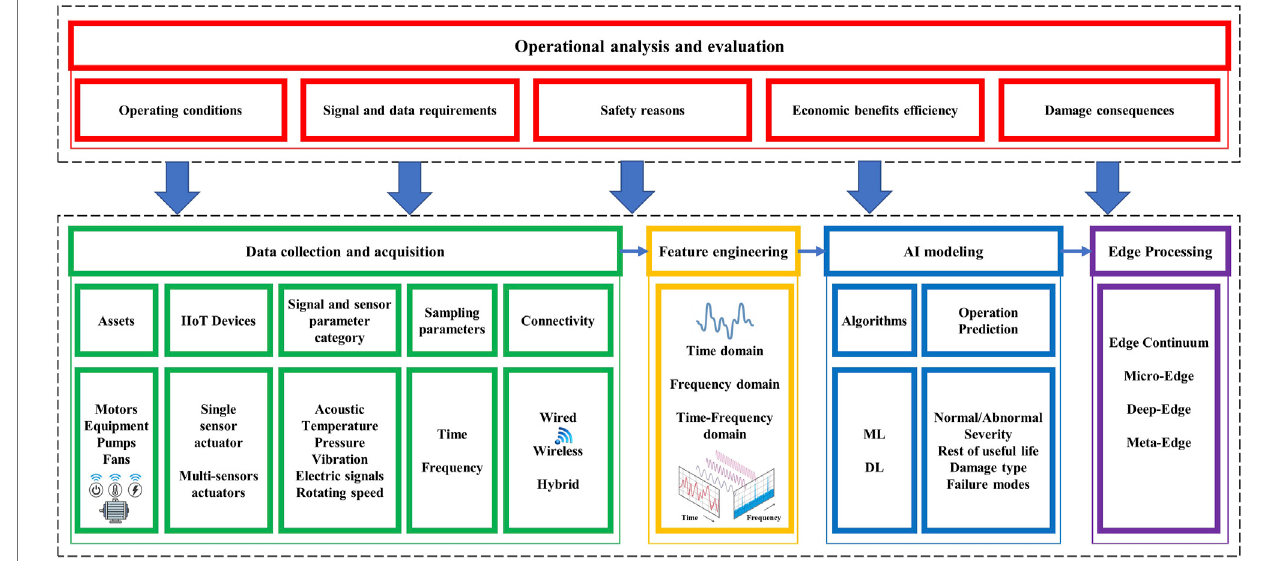
FIGURE 4 | Design methodology framework for PdM edge intelligence